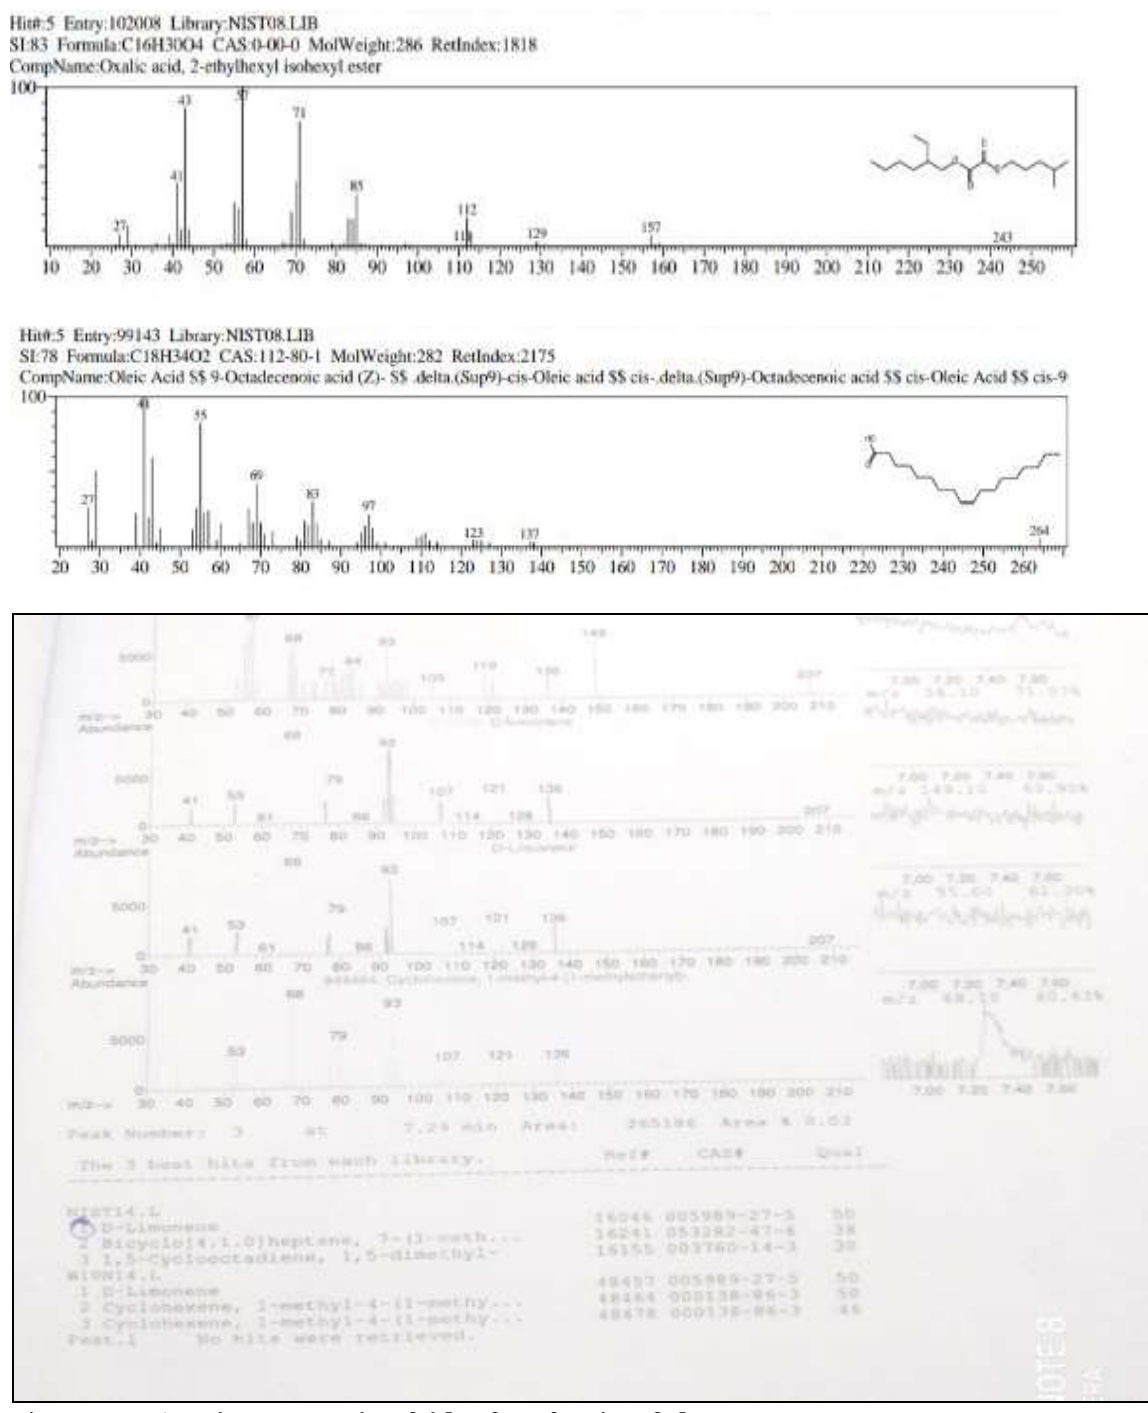
Figure 14.GC/MS chromatography of chloroform fraction of plant